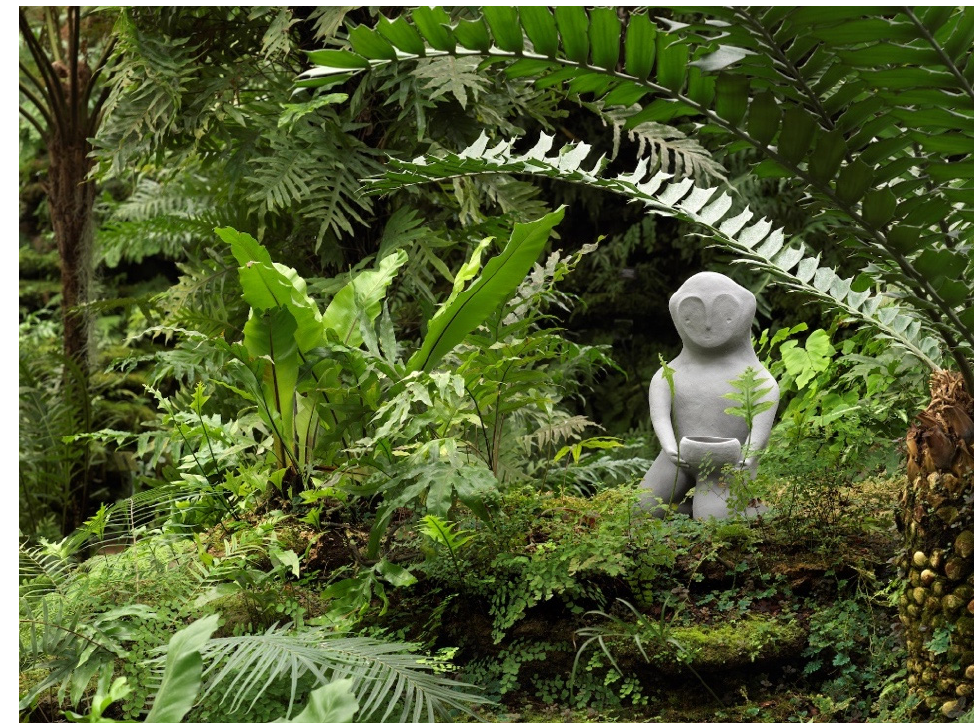
Figure 2. A Genius of the Spot III, 2020, glazed ceramic, 23 ″ × 11 ″ × 11 ″ .